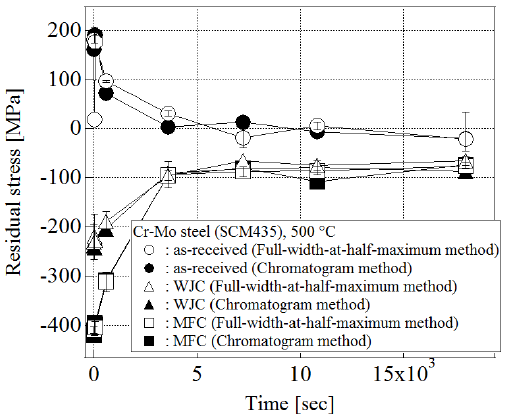
Appl. Sci. 2019 , 9 , 299 Figure 3. Time dependence of residual stress for Cr–Mo steel (SCM435). Figure 3. Time dependence of residual stress for Cr–Mo steel (SCM435).